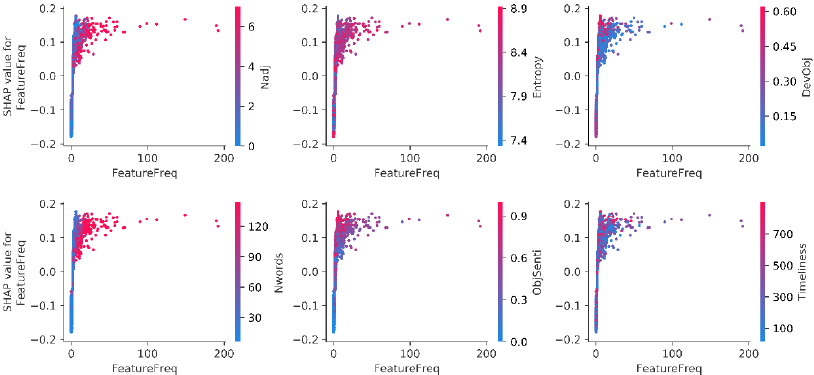
Figure 8. Individual joint feature contribution on the facial cleanser dataset. (Source of data: https://www.amazon.cn).